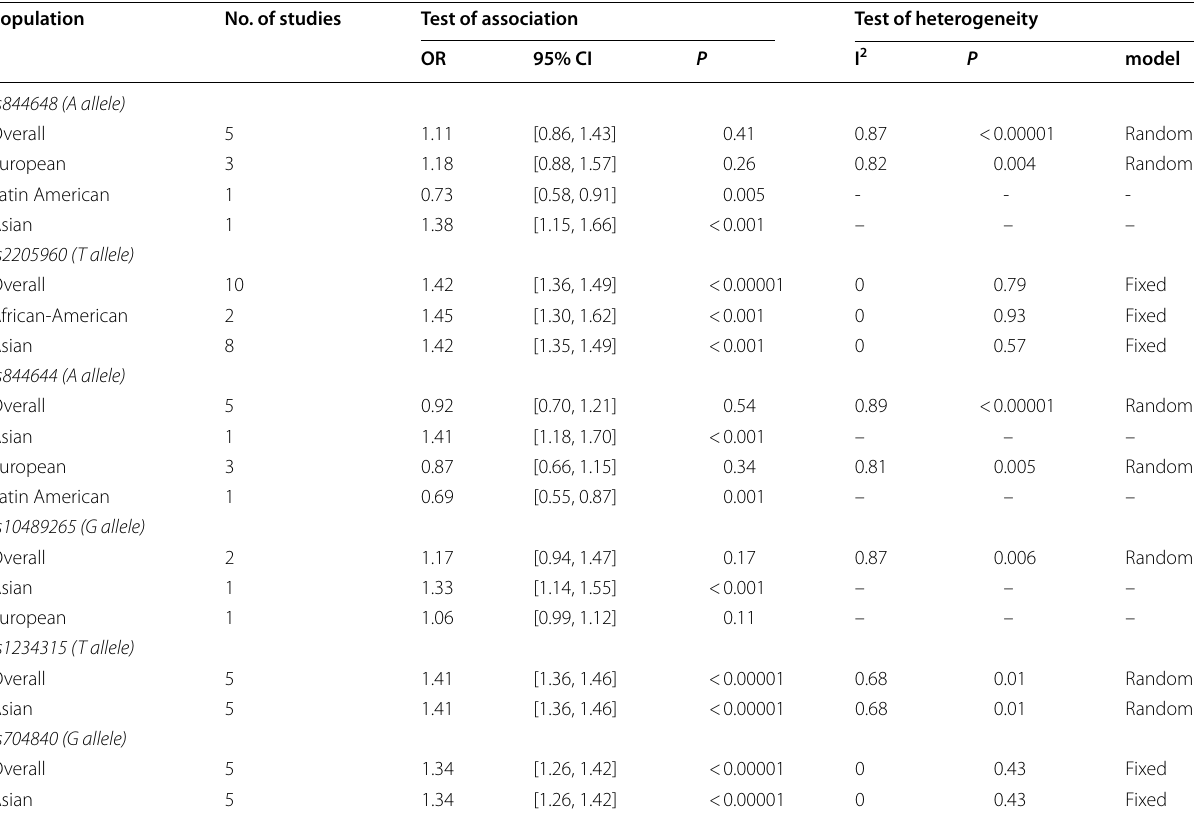
Table 3 Meta‑analysis of the association between the TNFSF4 polymorphisms and SLE